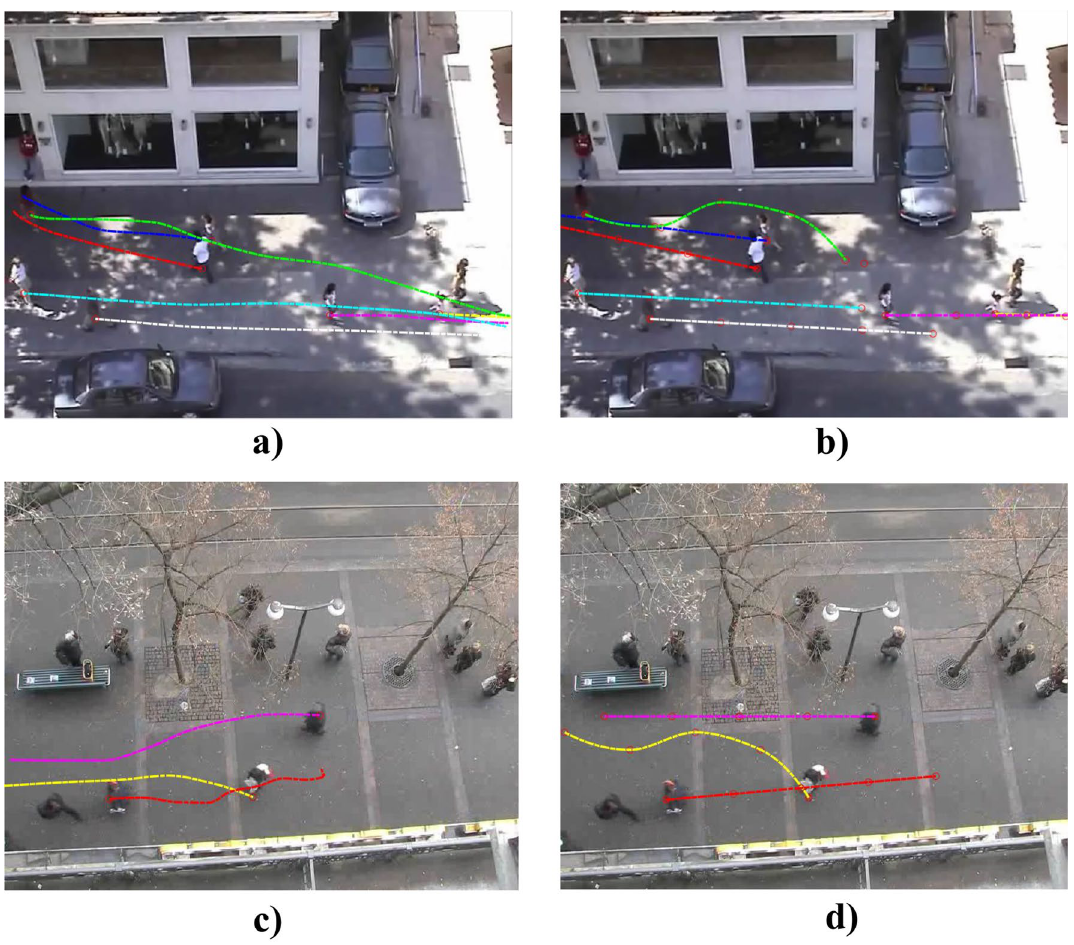
Figure 2. Validation of our human motion model based on game-theoretical approach with open-source surveillance videos 38 . ( a )–( c ) Real human trajectories; ( b )–( d ) Trajectories output of the game-theoretical